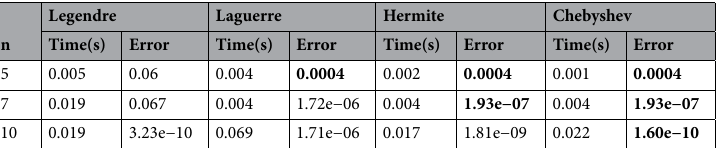
Table 10. Comparision of maximum relative error of z 1 ( t ) for Example 7.2 with different numbers of neurons. Significant values are in bold.